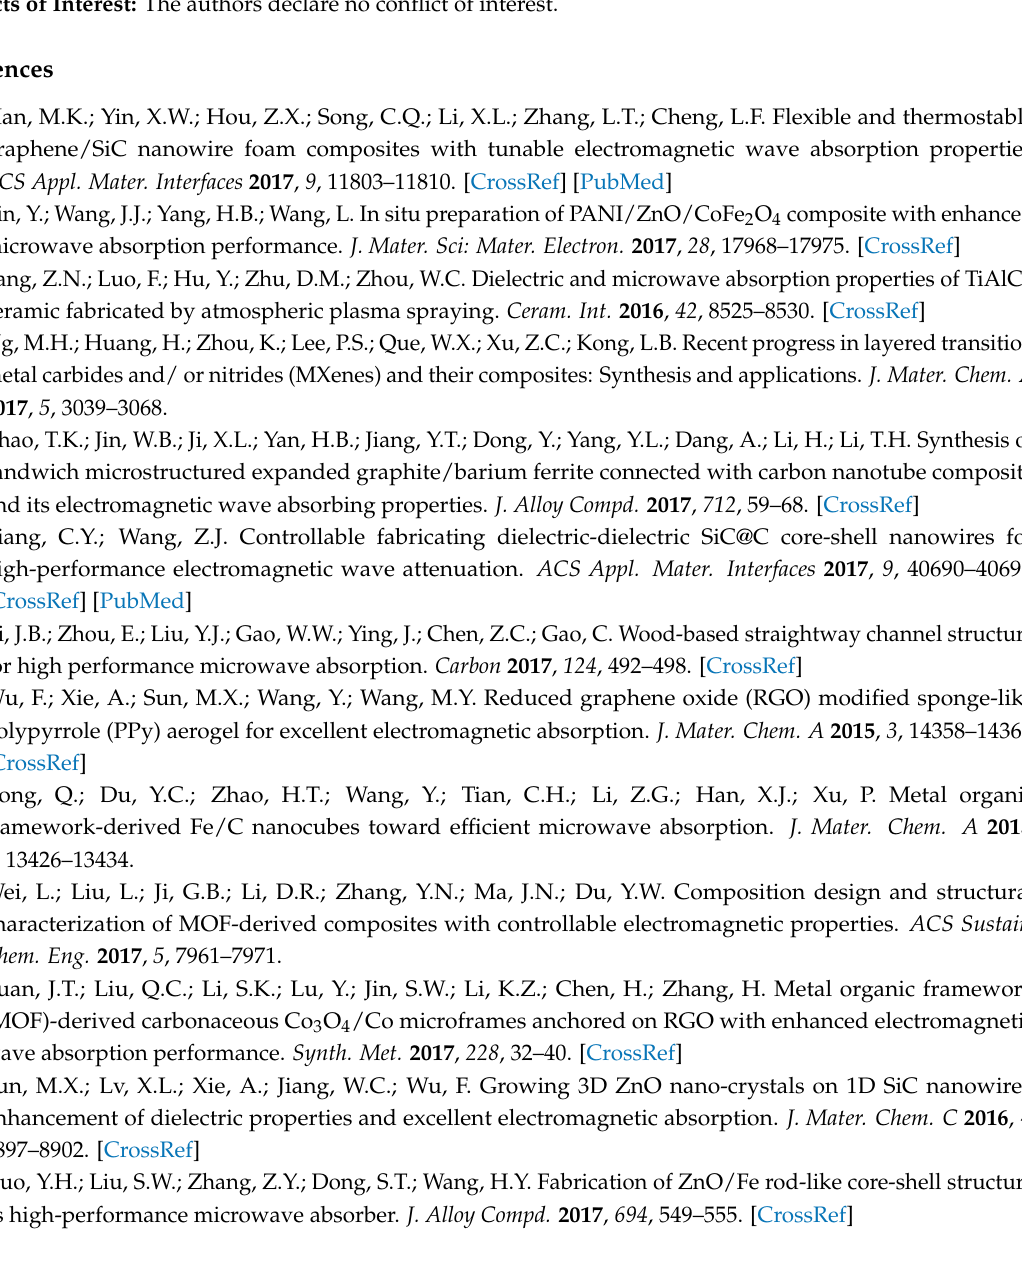
Figure S1: (a–d) elemental mapping images of 5% CNT composite; Figure S2: (a) XPS survey of the 5% CNT composite; (b) the crystal structure of Ni 3 ZnC 0.7 particles; Figure S3: The picture of the atmosphere protection tube furnace in the experimental process; Figure S4: (a,b) TEM images of raw MWCNT(a) and acid treated CNT(b); Figure S5: Raman images of raw CNT and acid treated CNT; Figure S6: (a) The chemical structure of Ni 3 ZnC 0.7 (b) The MOF structure of CCDC: 638866. Table S1: EDS results of the